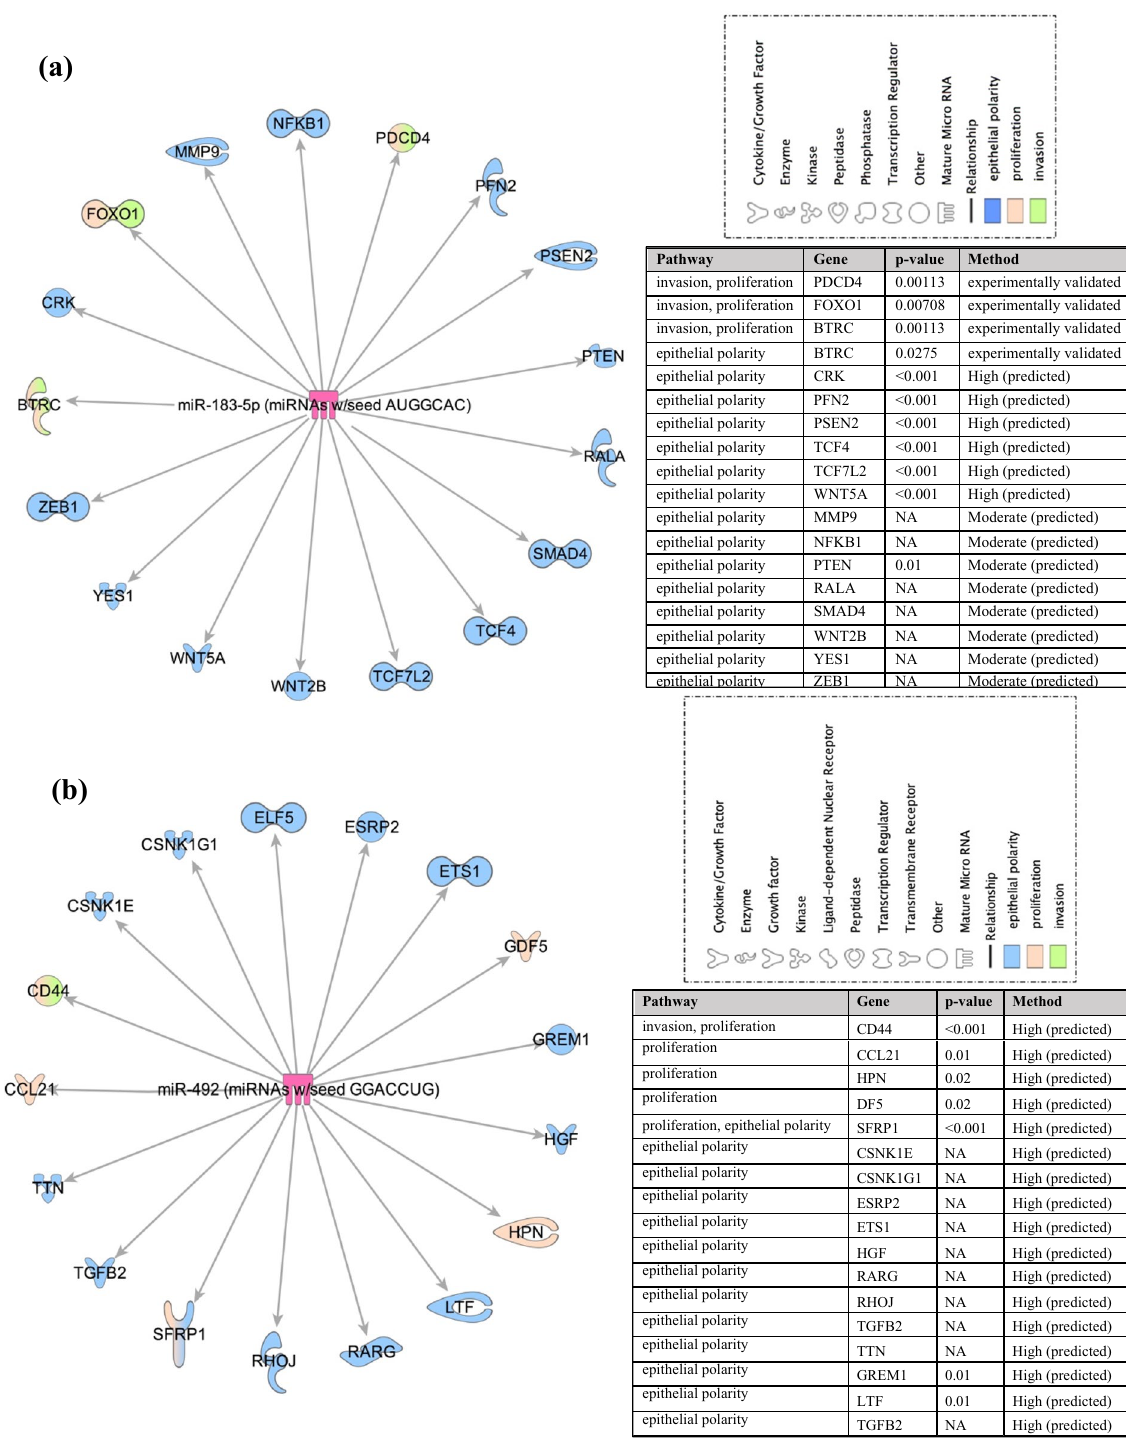
Figure 5. Potential downstream targets of miR pathways.